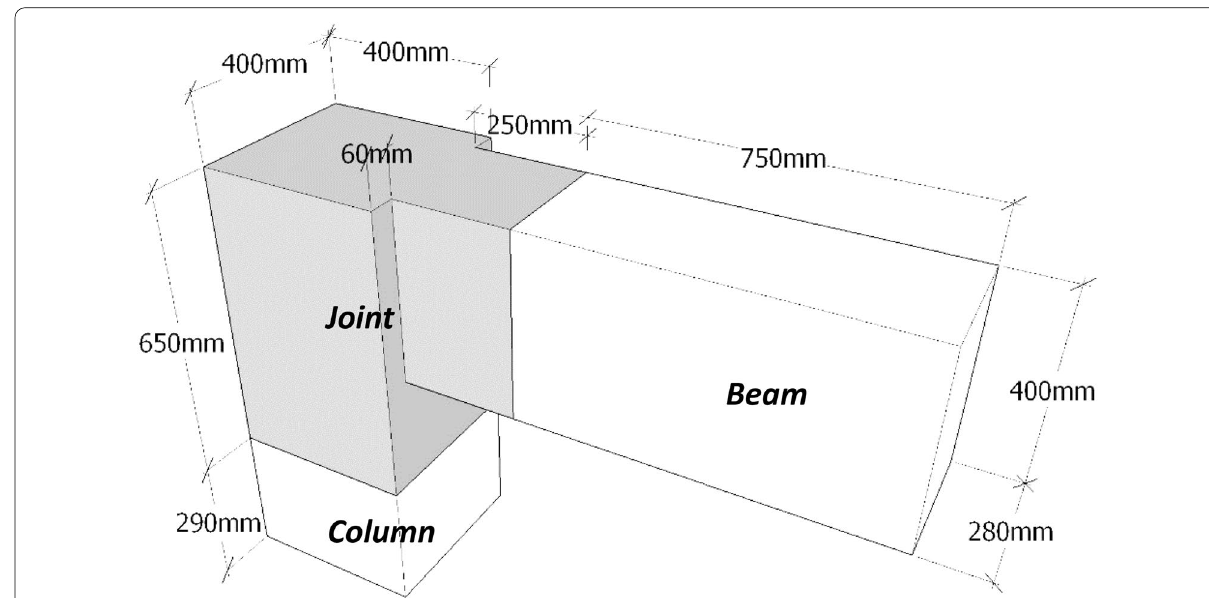
Fig. 3 Specimen Geometric Details with shaded regions as the HyFRC